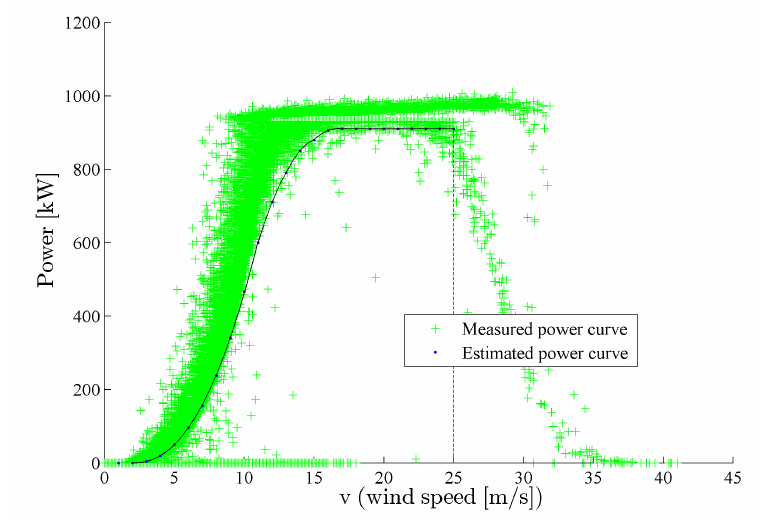
Figure 4. Measured power curve vs. estimated curve for the E44 turbine.